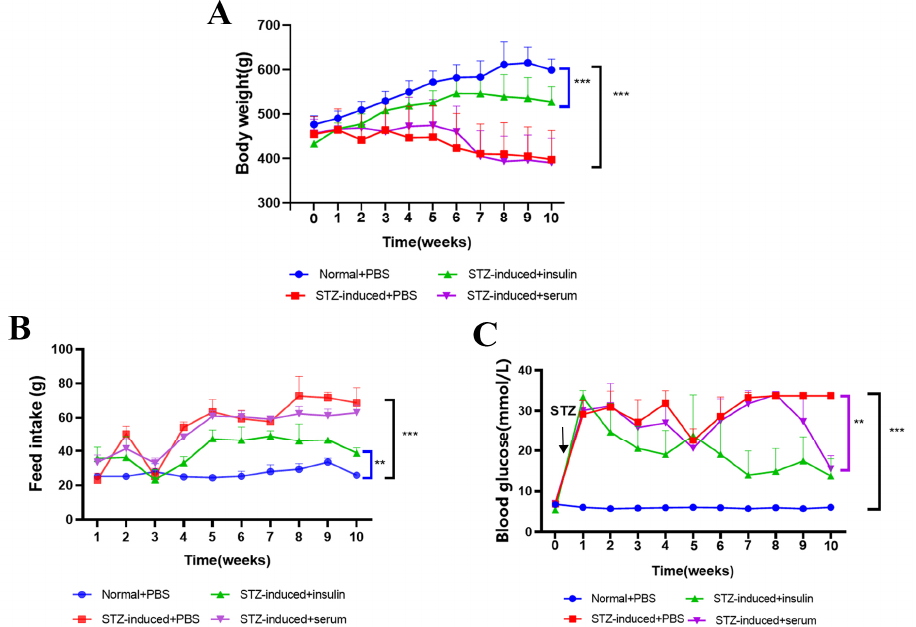
Figure 3. Effects of chicken serum treatment on feed intake, body weight, and blood glucose of rats. ( A ) The body weight of each group was determined every week. ( B ) The feed intake of each group was determined every week ( C ). Blood glucose levels of each group were after fasting for 3 h determined every week. All values of ( A – C ) are mean ± SE n = 6 rats per group, with ** p < 0.01, *** p < 0.001, determined by one-way ANOVA.